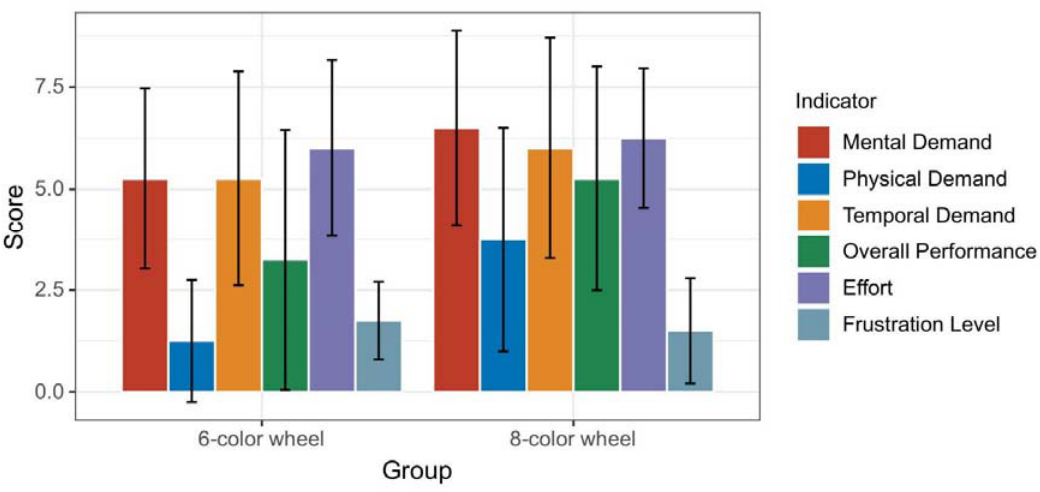
Figure 7. Workload assessment scores for NASA-TLX test question indicators.